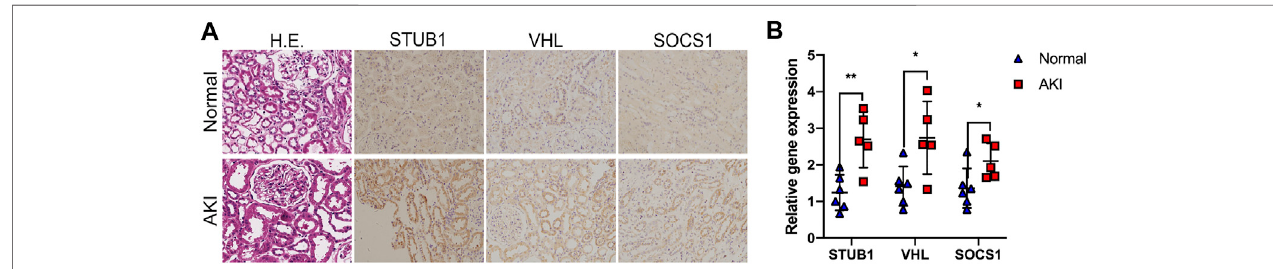
FIGURE 6 | Validation of the upregulated hub genes in human AKI tissues. (A) Representative images of HE and IHC staining of the kidney tissues from AKI and normal kidneys, as indicated. Magni fi cation × 200. (B) qPCR of STUB1, VHL, and SOCS1 mRNA levels in fi ve AKI tissues and six normal kidney tissues. * p < 0.05, ** p < 0.01, compared to control.